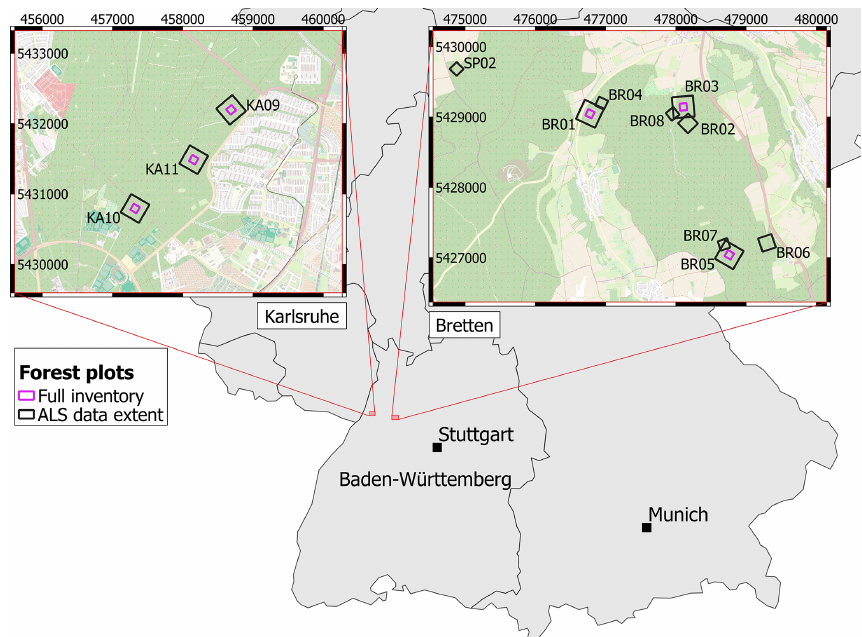
Figure 2. Map of the forest plots in Karlsruhe (left) and Bretten (right) in the federal state of Baden-Württemberg, Germany. The extent of the extracted ALS data is outlined in black, and areas for which field measurements were conducted are outlined in purple (“Full inventory”). All plots except BR04 are covered by the ULS acquisitions. TLS was performed in selected locations within the plots. Coordinates are given in the projected coordinate system ETRS89/UTM zone 32N (EPSG:25832). Map data: © OpenStreetMap contributors 2021. Distributed